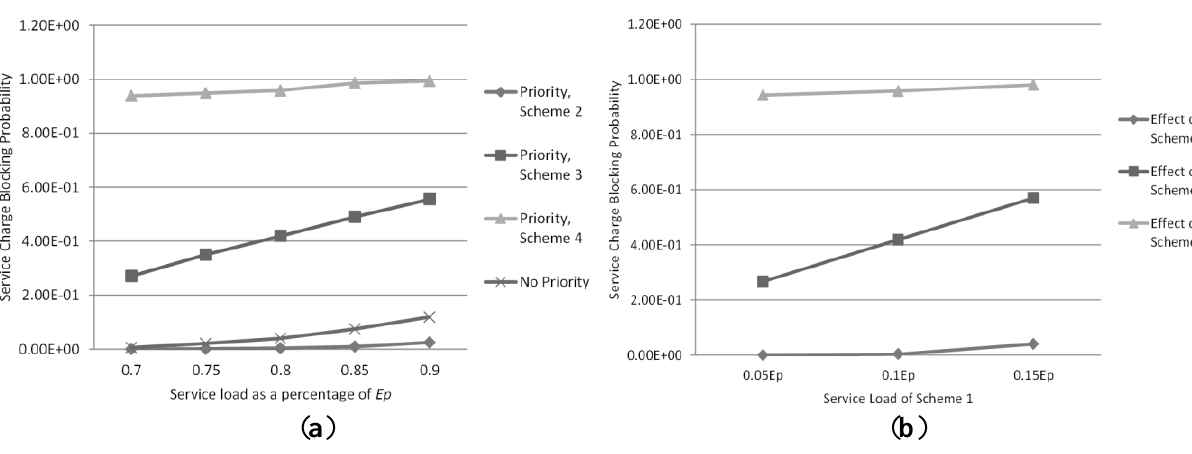
Figure 7. The effect of total service load and scheme 1 on the service charge of scheme 2, 3, and 4. ( a ) Effect of increasing the overall service load on the various schemes, when the service load of scheme 1 is 0.10 E ; ( b ) Effect of increasing the service demand of scheme p 1 on the other schemes when the total service load is 0.8 E p